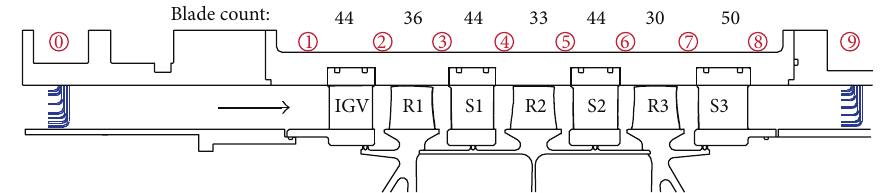
Figure 2: A cross-section of the flow path including data acquisition stations.